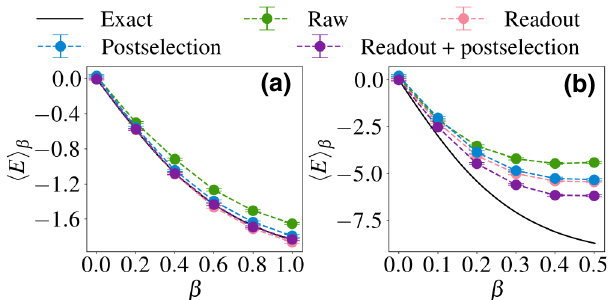
FIG. 5. Finite-temperature energy (cid:9) E (cid:7) β of (a) the two-site TFIM with J = h = 1 and (b) the four-site TFIM with J = 3, h = 1, simulated with measurement sampling and the noise model from ibmq_rome . The imaginary-time-step size in QITE is (cid:3)τ = 0.1 for two-site TFIM and (cid:3)τ = 0.05 for four-site TFIM. Raw data are postprocessed at each imaginary time step with either readout error mitigation, or postselection, or both. Employ- be most effective in mitigating the errors.